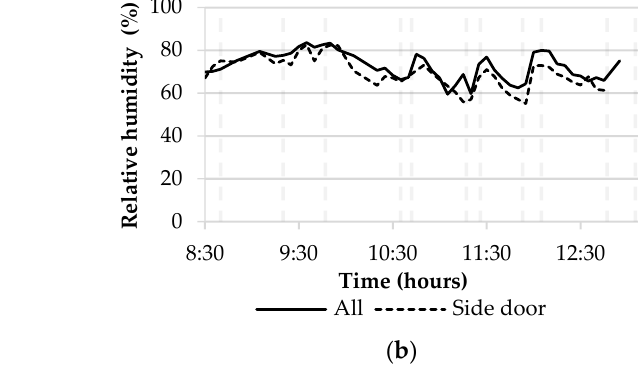
Figure 12. Average of all the sensor readings versus the average of the readings from sensors near the side door for temperature ( a ) and relative humidity ( b ).